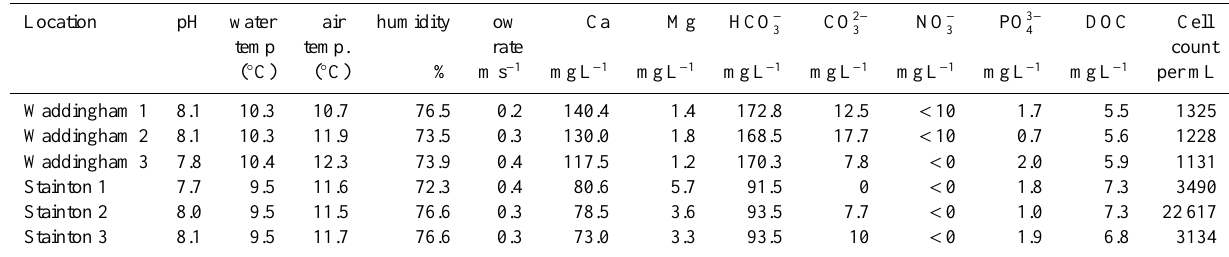
Table 3. Mean field data for sites at Stainton and Waddingham, Lincolnshire, UK. Location